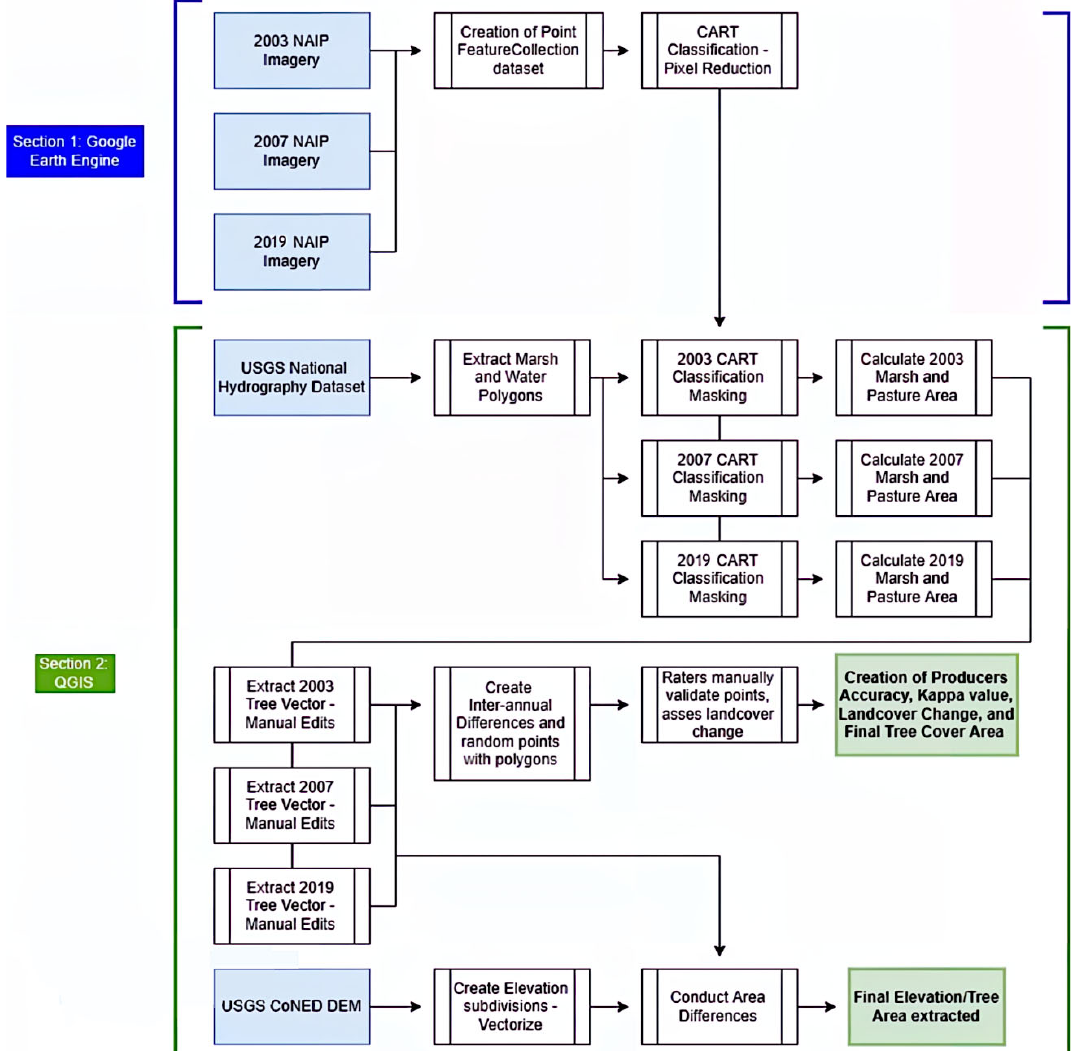
Figure 3. Process workflow used in the study. The section bracketed in blue was processed using Google Earth Engine and the section bracketed in green was carried out using QGIS. Blue blocks represent raw inputs into the workflow; green blocks are the final outputs.